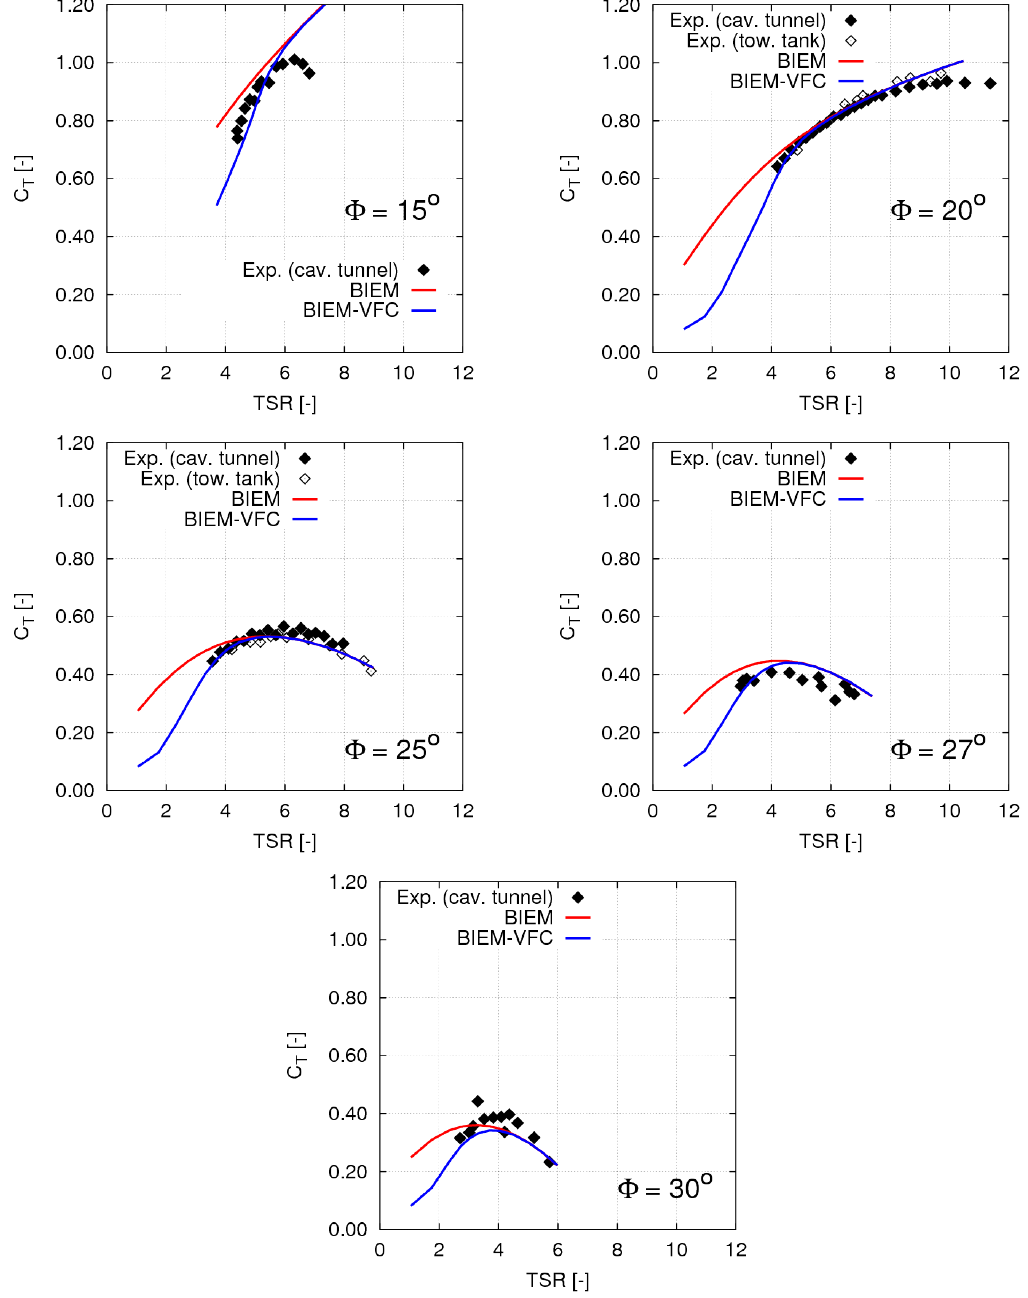
Figure 25. UoS-VP turbine performance predictions by BIEM and BIEM-VFC compared to experimental data in [13]. Thrust coefficient at pitch settings Φ = 15 ◦ ,20 ◦ ,25 ◦ ,27 ◦ ,30 ◦